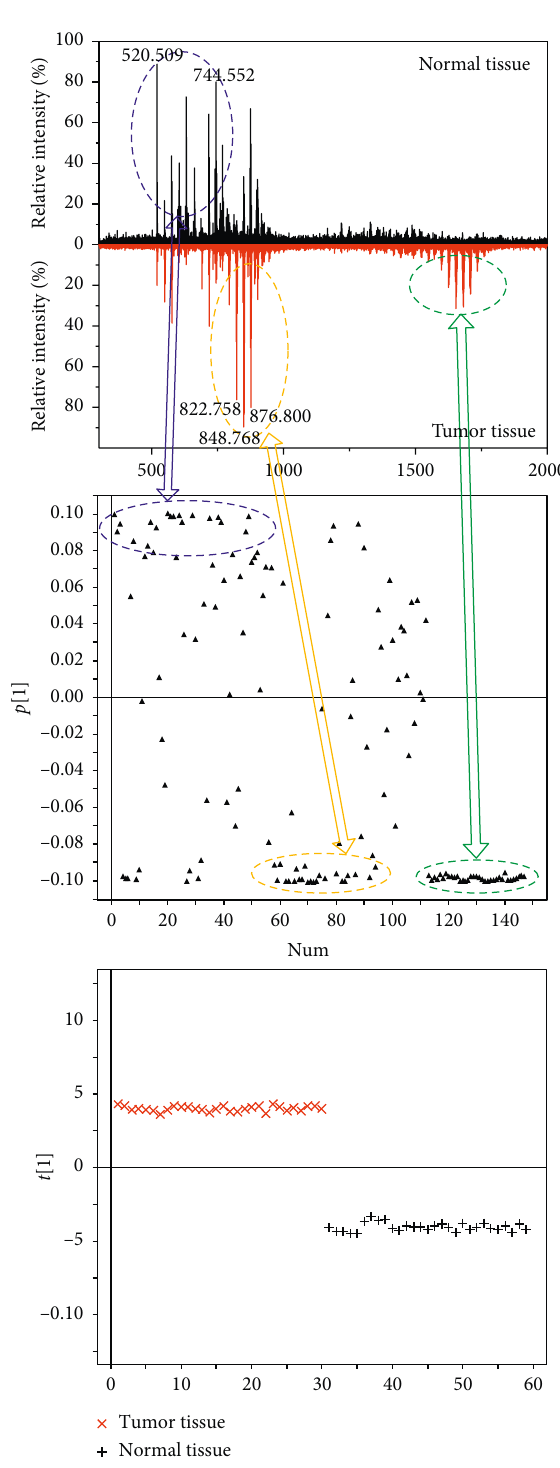
Figure 6: (a) Typical spectra of healthy tissue and tumor tissue, (b) the loading plot for mass spectra data with PCA, and (c) the PCA score plot explains 88.6% of the variance using one component and showed separation between healthy tissue and tumor